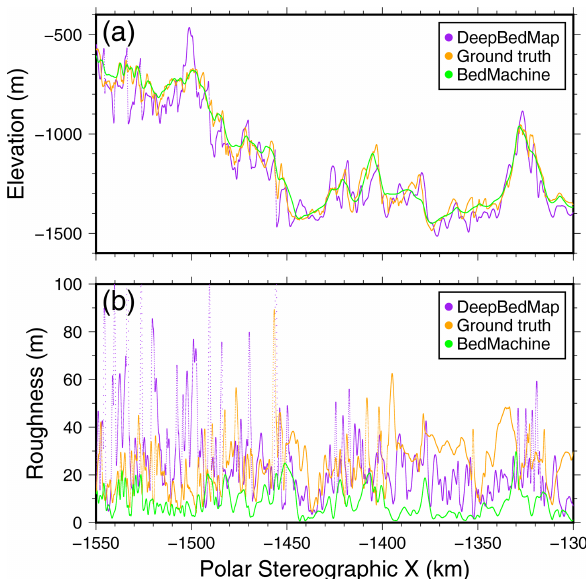
Figure 6. Comparing bed elevation (a) and surface roughness (b) (SD of elevation values) of each interpolated grid product (250m resolution) over a transect (see Fig. 5 for location of transect line). Purple values are from the super-resolution DeepBedMap_DEM; orange values are from tension-spline-interpolated Operation Ice- Bridge ground-truth points; green values are from bicubically inter- polated BedMachine